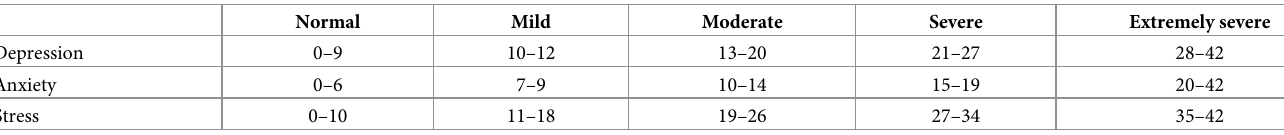
Table 1. Categorization and score range of DASS-21